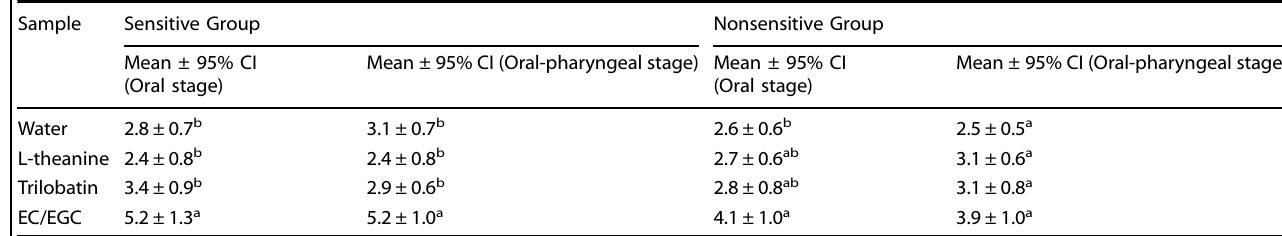
Table 1. The Huigan intensity of the tea compound solutions rated by sensitive and nonsensitive group in the oral and oral-pharyngeal stage. Sample Sensitive Group